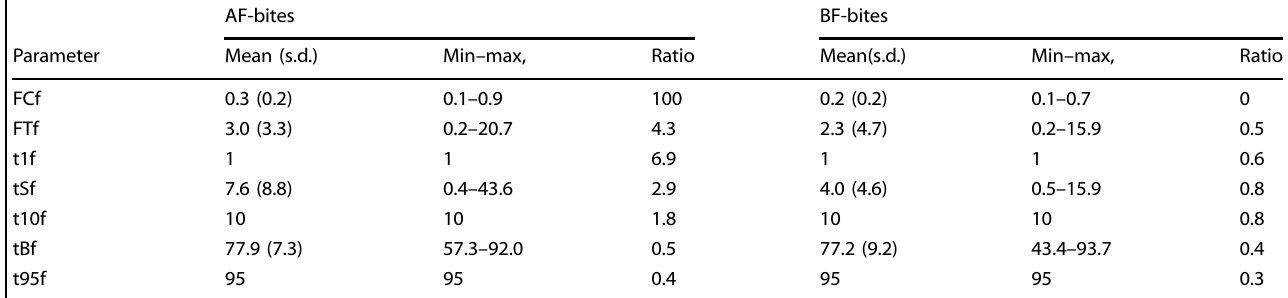
Table 2. The force parameters. The values the force parameters and the ANT/BAT ratio are given in % of the mFpr